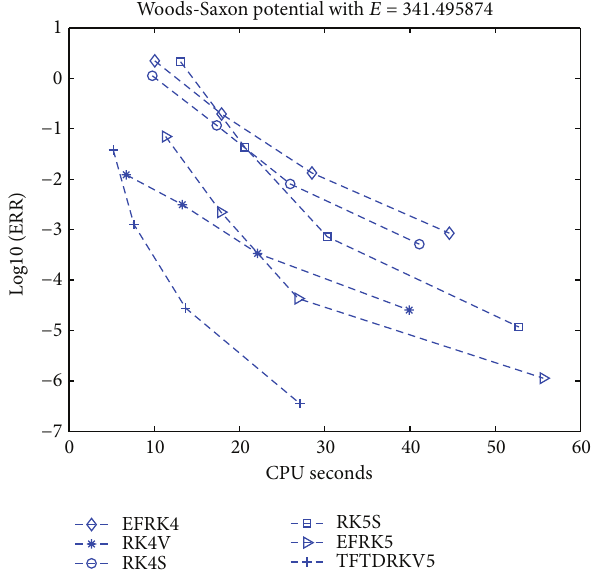
Figure 4: Efficiency curves for Problem 1: 𝐸 = 341.495874